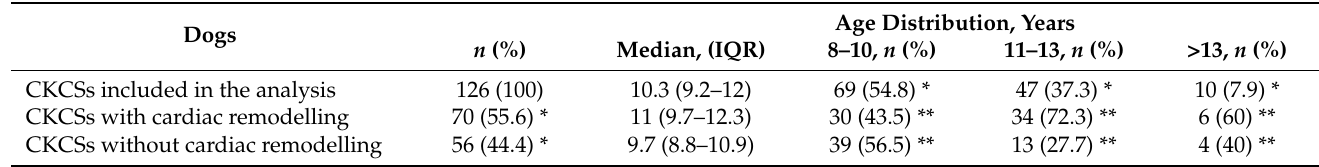
Table 3. Age distribution of